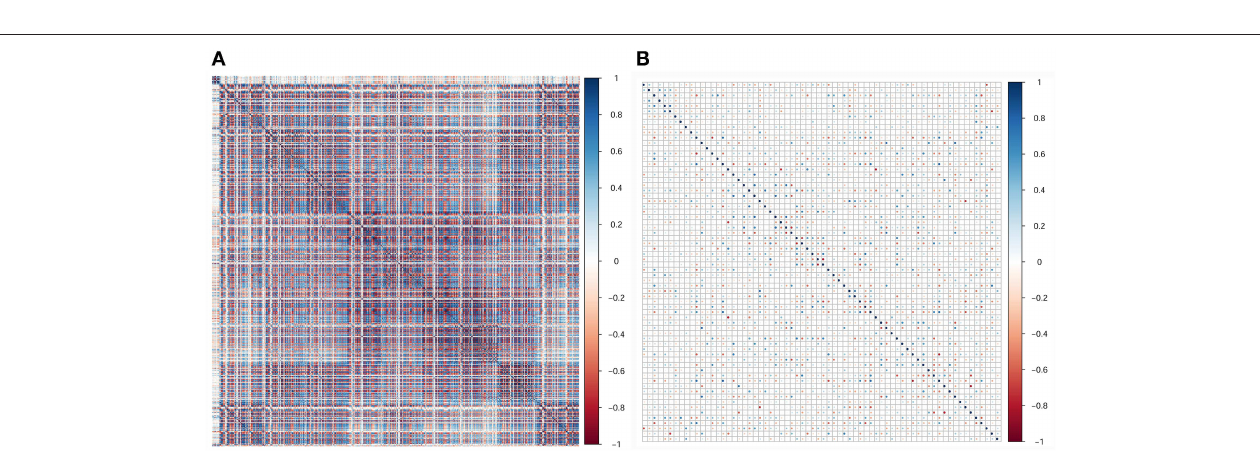
FIGURE 3 | Correlation matrix heatmaps of the features before (A) and after (B) correlation filtering. Before correlation filtering, a mass of redundant features with high correlation coefficients existed.